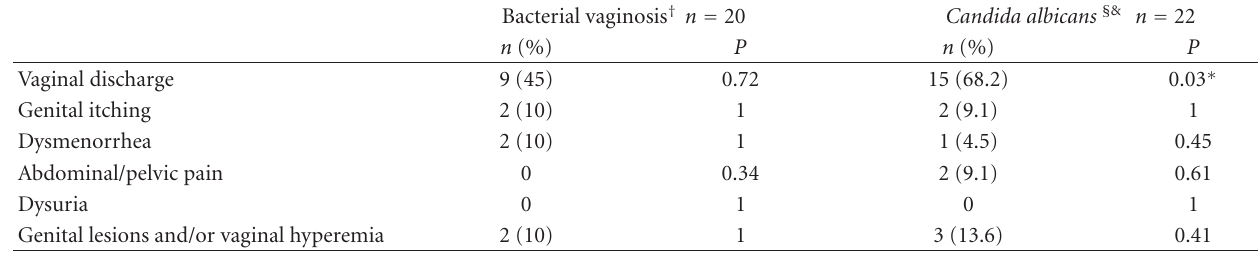
Table 2: Current genitourinary signs and symptoms of the study population, stratified by the diagnosis of bacterial vaginosis (BV) or genital Candida albicans infection ( n =